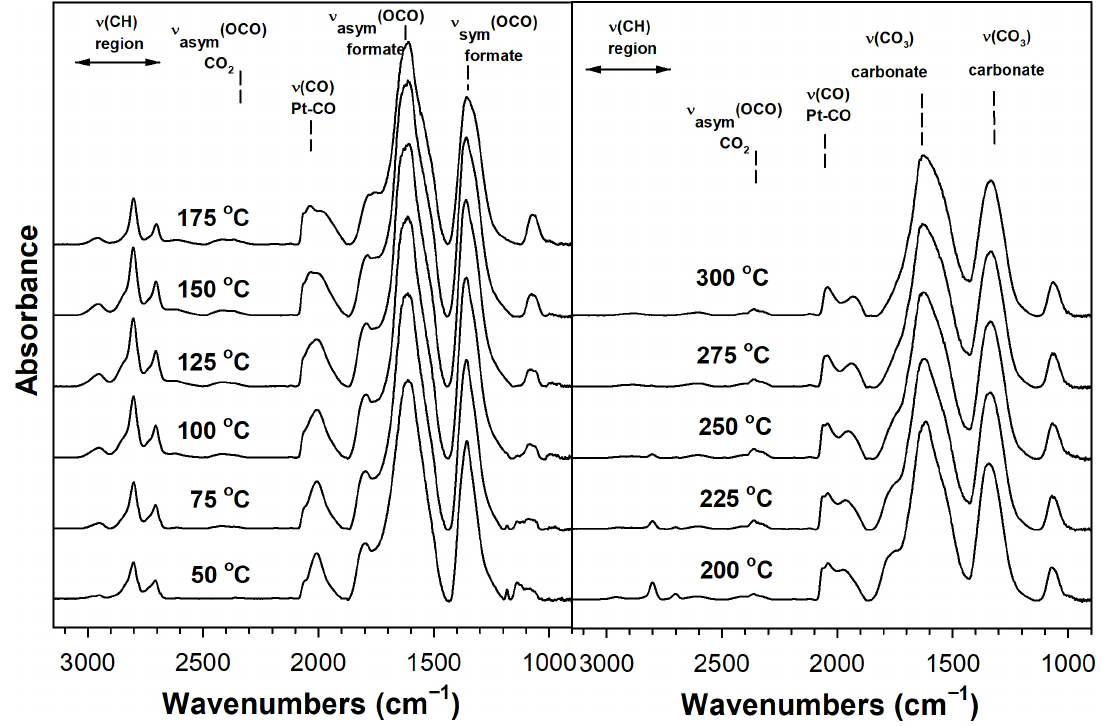
Figure 5. DRIFTS of steam reforming of formaldehyde over 1.8%Na-2%Pt/m-ZrO 2 .